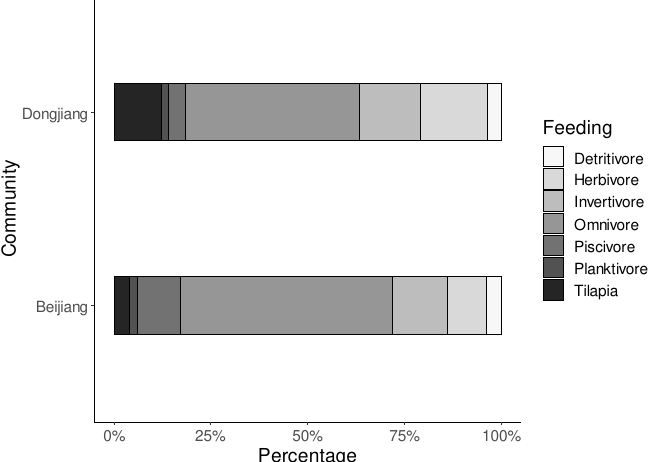
Figure 2. Quantity proportions of different feeding habits in the invaded Dongjiang River and the reference Beijiang River. Table 2. Fish community structure in the Dongjiang River and Beijiang River.